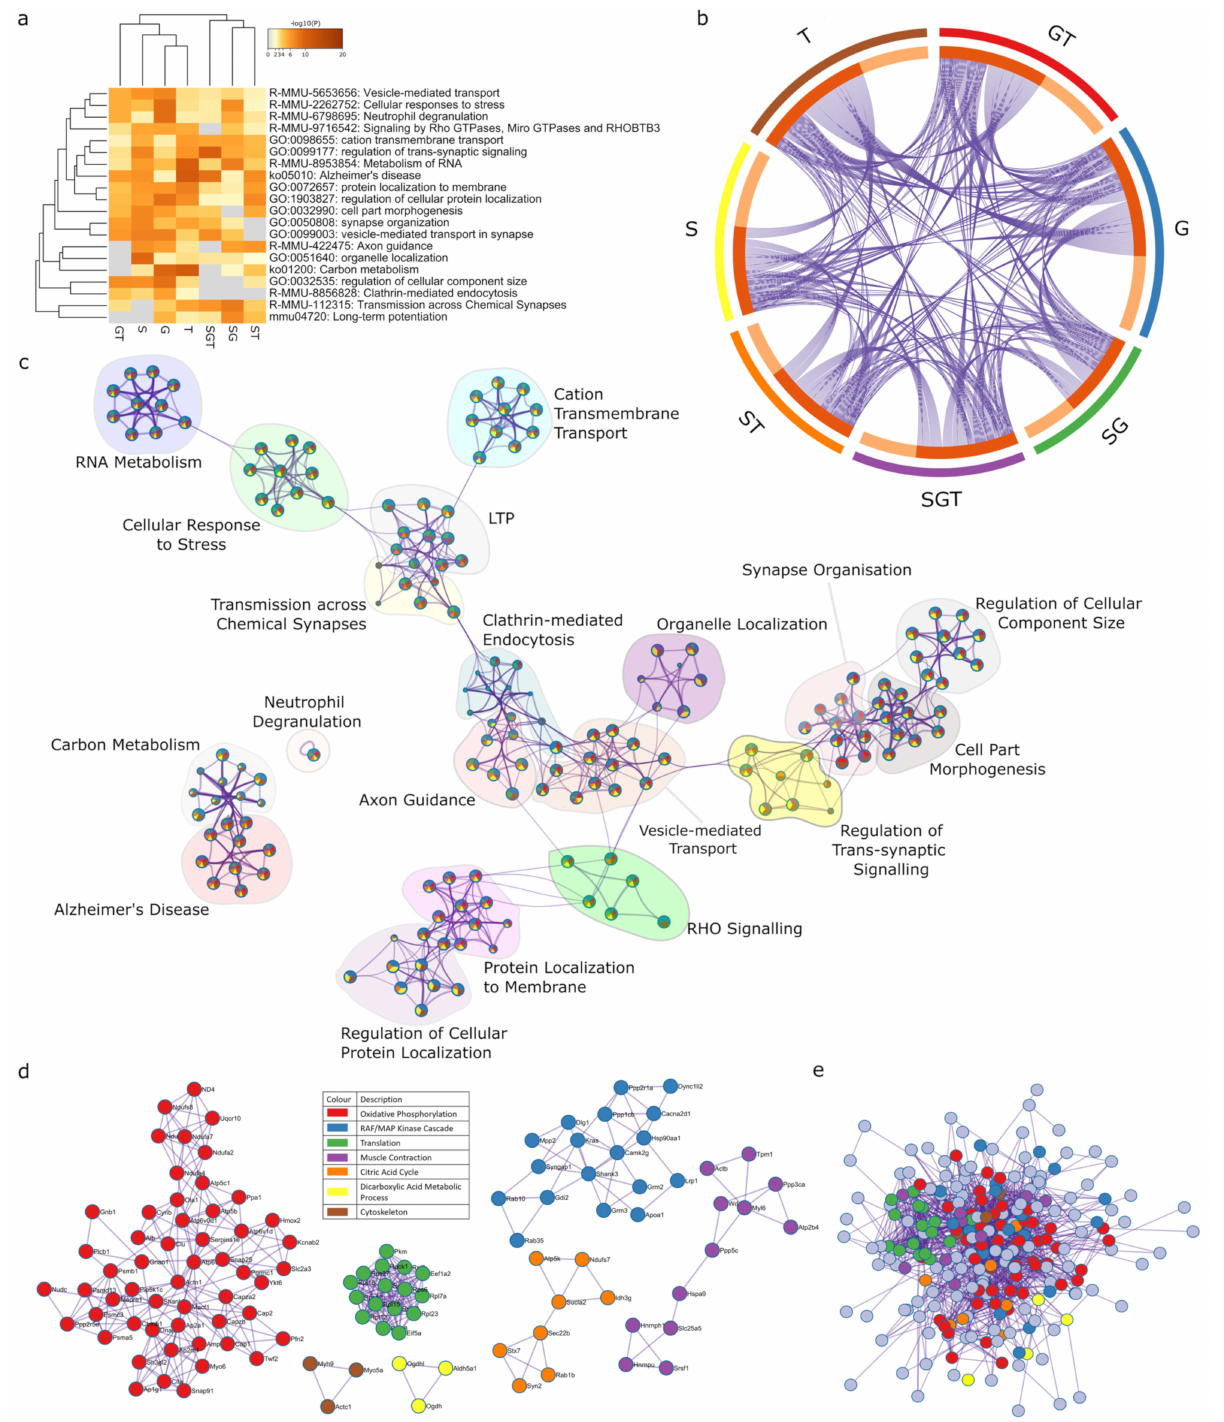
Figure 8. Meta-analysis of proteins significantly regulated by sex, gonads and Tibolone. The proteins identified as being regulated by sex, gonads or Tibolone, as well as all potential interactions, were input into Metascape for functional enrichment analysis, and then, cross referenced to see which functions were significantly enriched across the most protein lists. A heatmap of the top 20 most enriched functions across each list ( a ) is shown, with darker squares indicating higher statistical significance. The 5 most significant functions identified were Alzheimer’s disease ( q = 4.68 × 10 − 23 ), metabolism of RNA ( q = 1.78 × 10 − 22 ), cellular response to stress ( q = 9.55 × 10 − 20 ), regulation of cellular protein localization ( q = 7.24 × 10 − 19 ) and vesicle-mediated transport in synapse ( q = 1.07 × 10 − 18